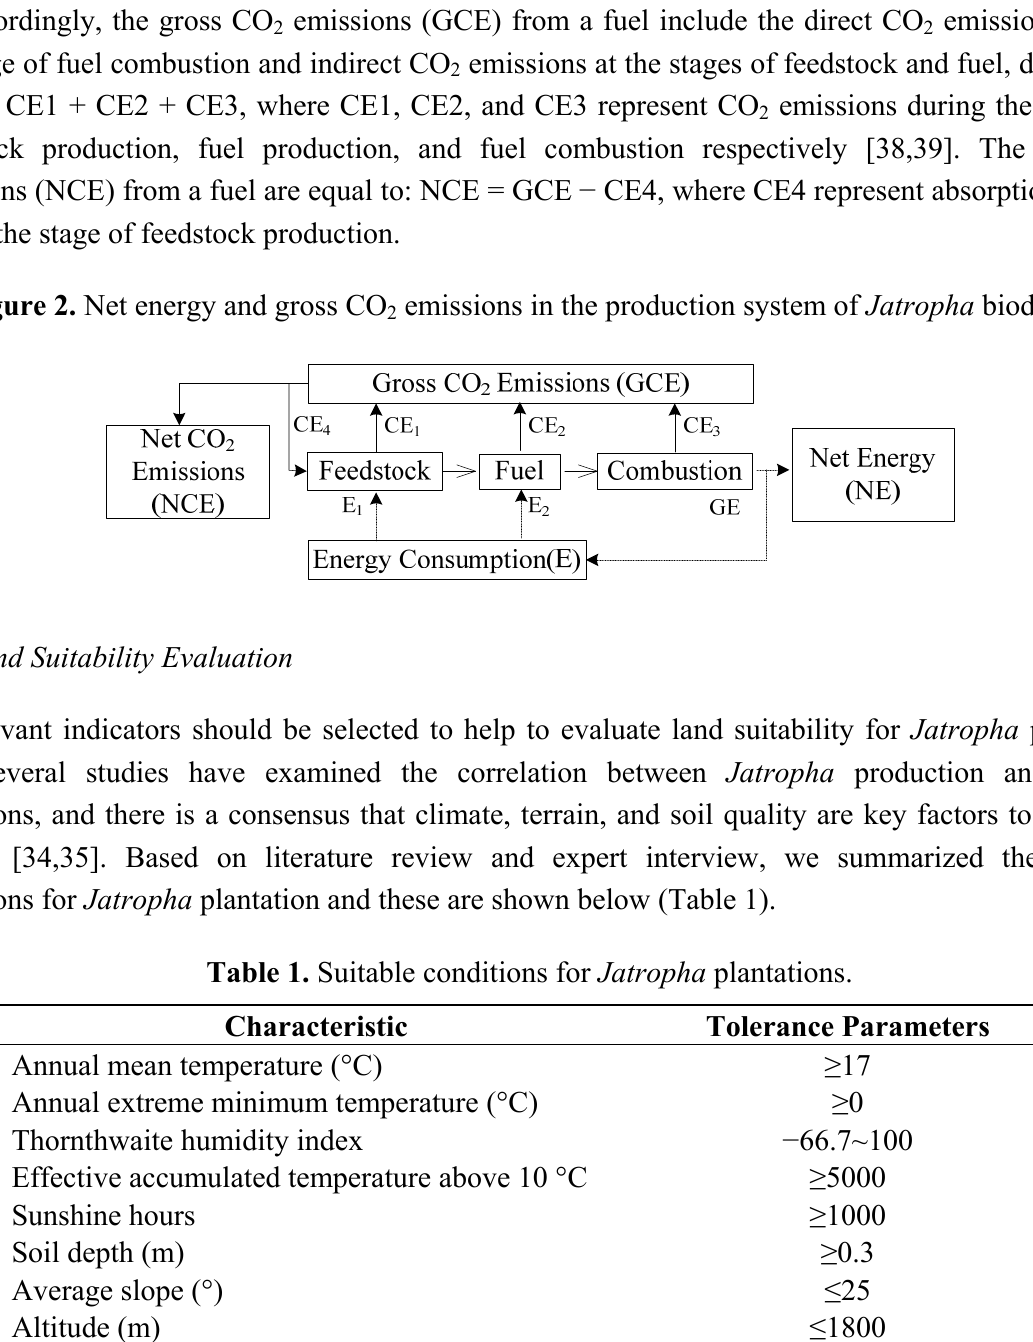
Figure 2. Net energy and gross CO